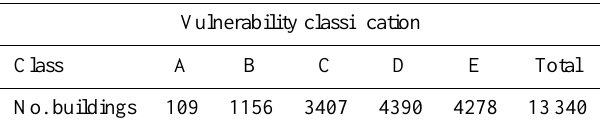
Table A1. Vulnerability classification of the buildings inside the aggregate inundation area under the assumption of maximum high-tide. It extends over 16km 2 .